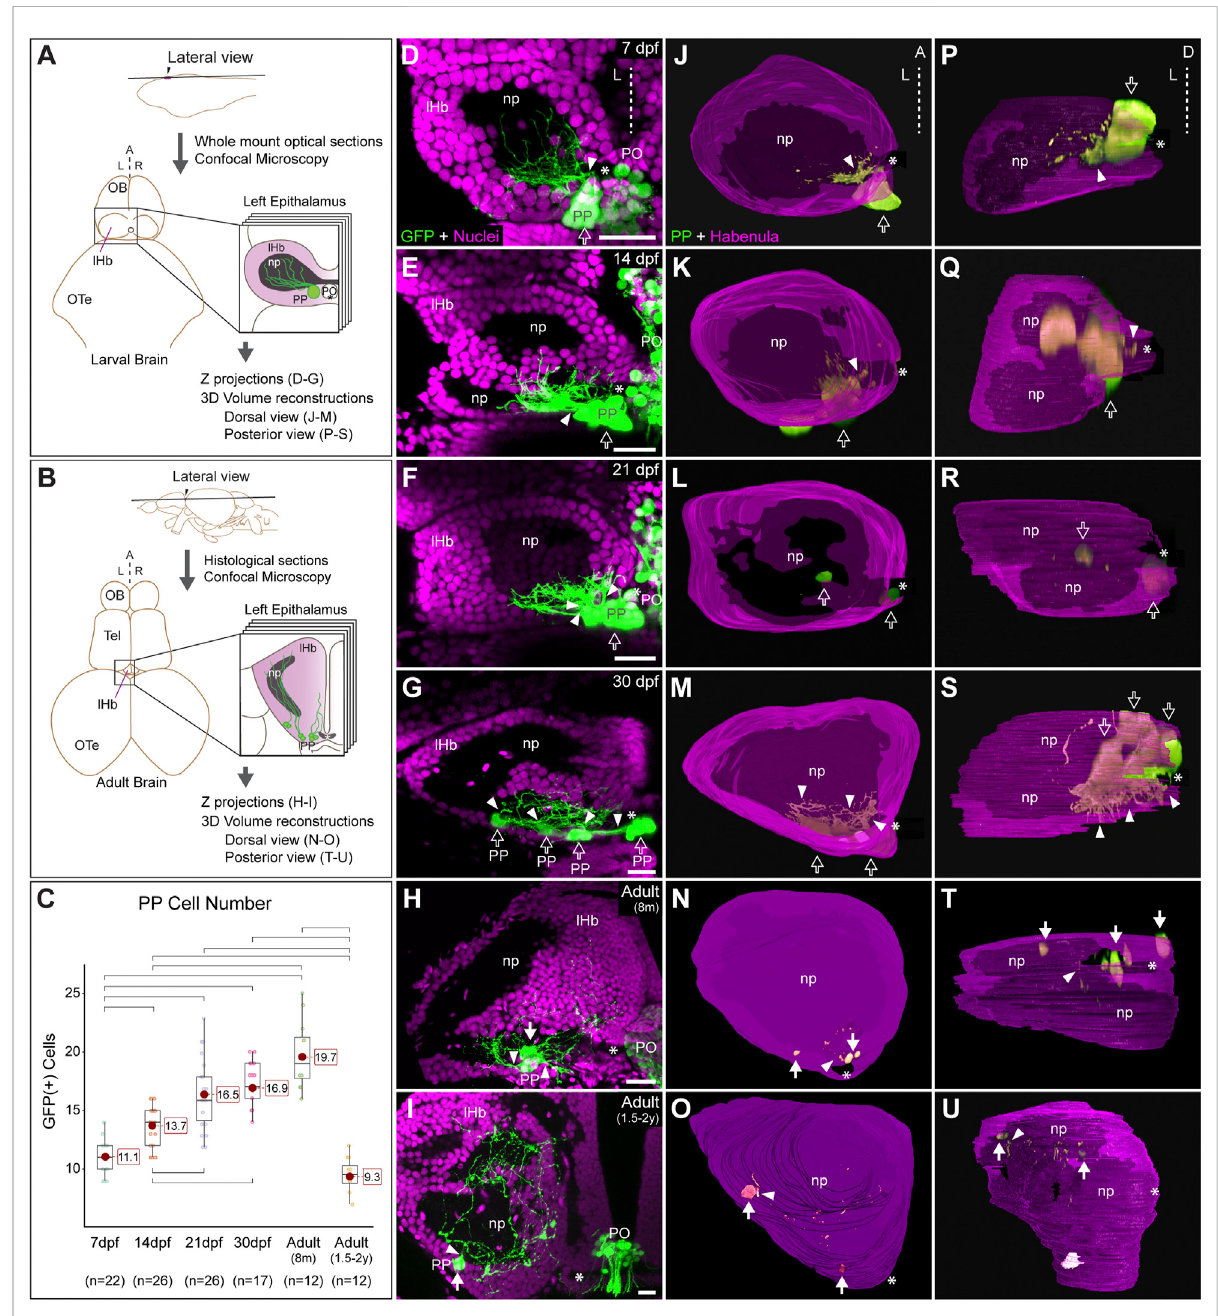
FIGURE 1 Post-hatching ontogeny of parapineal morphology and connectivity in zebra fi sh. (A,B) Schemes of larval (A) and adult (B) zebra fi sh brains showingtheoverallanatomyoftheepithalamusindorsalviewsandthepositionofopticalandhistologicalsectionsanalysedintherestofthepanels. The left side of the epithalamus is highlighted and enlarged in a square containing the left habenula (magenta) and the parapineal (green). The positionofthehabenularcommissureisindicatedwithanasterisk. (C) Boxplotshowingthequanti fi cationofGFP(+)parapinealcellsinlarvae(7, 14 and 21 dpf), juveniles (30 dpf) and adults (8 mpf and 1.5 – 2 years old). N for each group are shown below the x-axis. Signi fi cance was set to p < 0.001 (upper square brackets) or p < 0.01 (lower square brackets). The red circle on each bar is the mean for the group and its value is indicated with red square labels. The horizontal line in the box is the median of the group. (D – I) Ontogeny of parapineal morphology and connectivity revealed by immuno fl uorescence against GFP (green) and DAPI/Hoechst staining (magenta) in Tg( foxd3::GFP ) zebra fi sh. Images correspond to dorsal views of representative confocal z-stacks maximum projections of the left epithalamus at 7 dpf (D) , 14 dpf (E) , 21 dpf (F) , 30 dpf (G) , 8 months (H) and 1.5 – 2 years old (I) , with anterior to the top, left to the left and the midline (dotted line) towards the right side of the panel. Arrowheads indicates the site where parapineal projections emerge, often forming a thick bundle at earlier stages. Empty arrows indicate the parapineal cell body as long it is recognizable as a single large cluster. White arrows indicate parapineal cell groups scattered along the posterior border of the left habenula. (J – O)